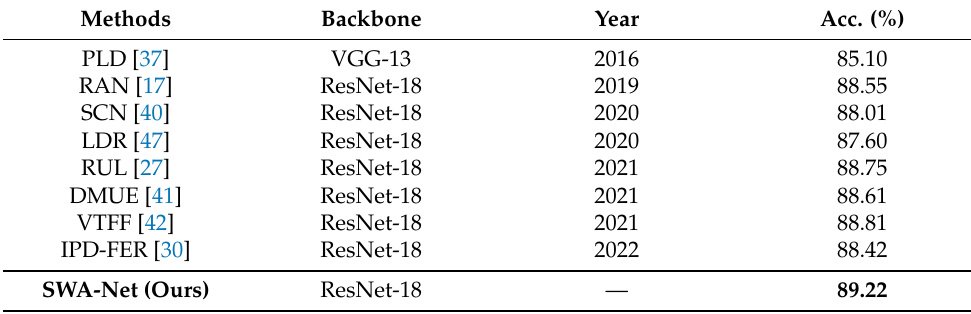
Table 7. Comparisons with the state-of-the-art methods on the FERPlus dataset.